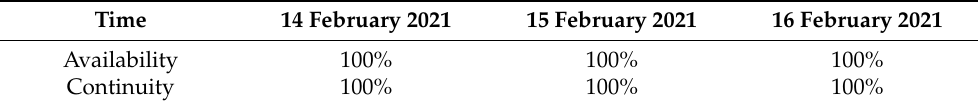
Table 3. The availability and continuity of two-way timing service (normal state).